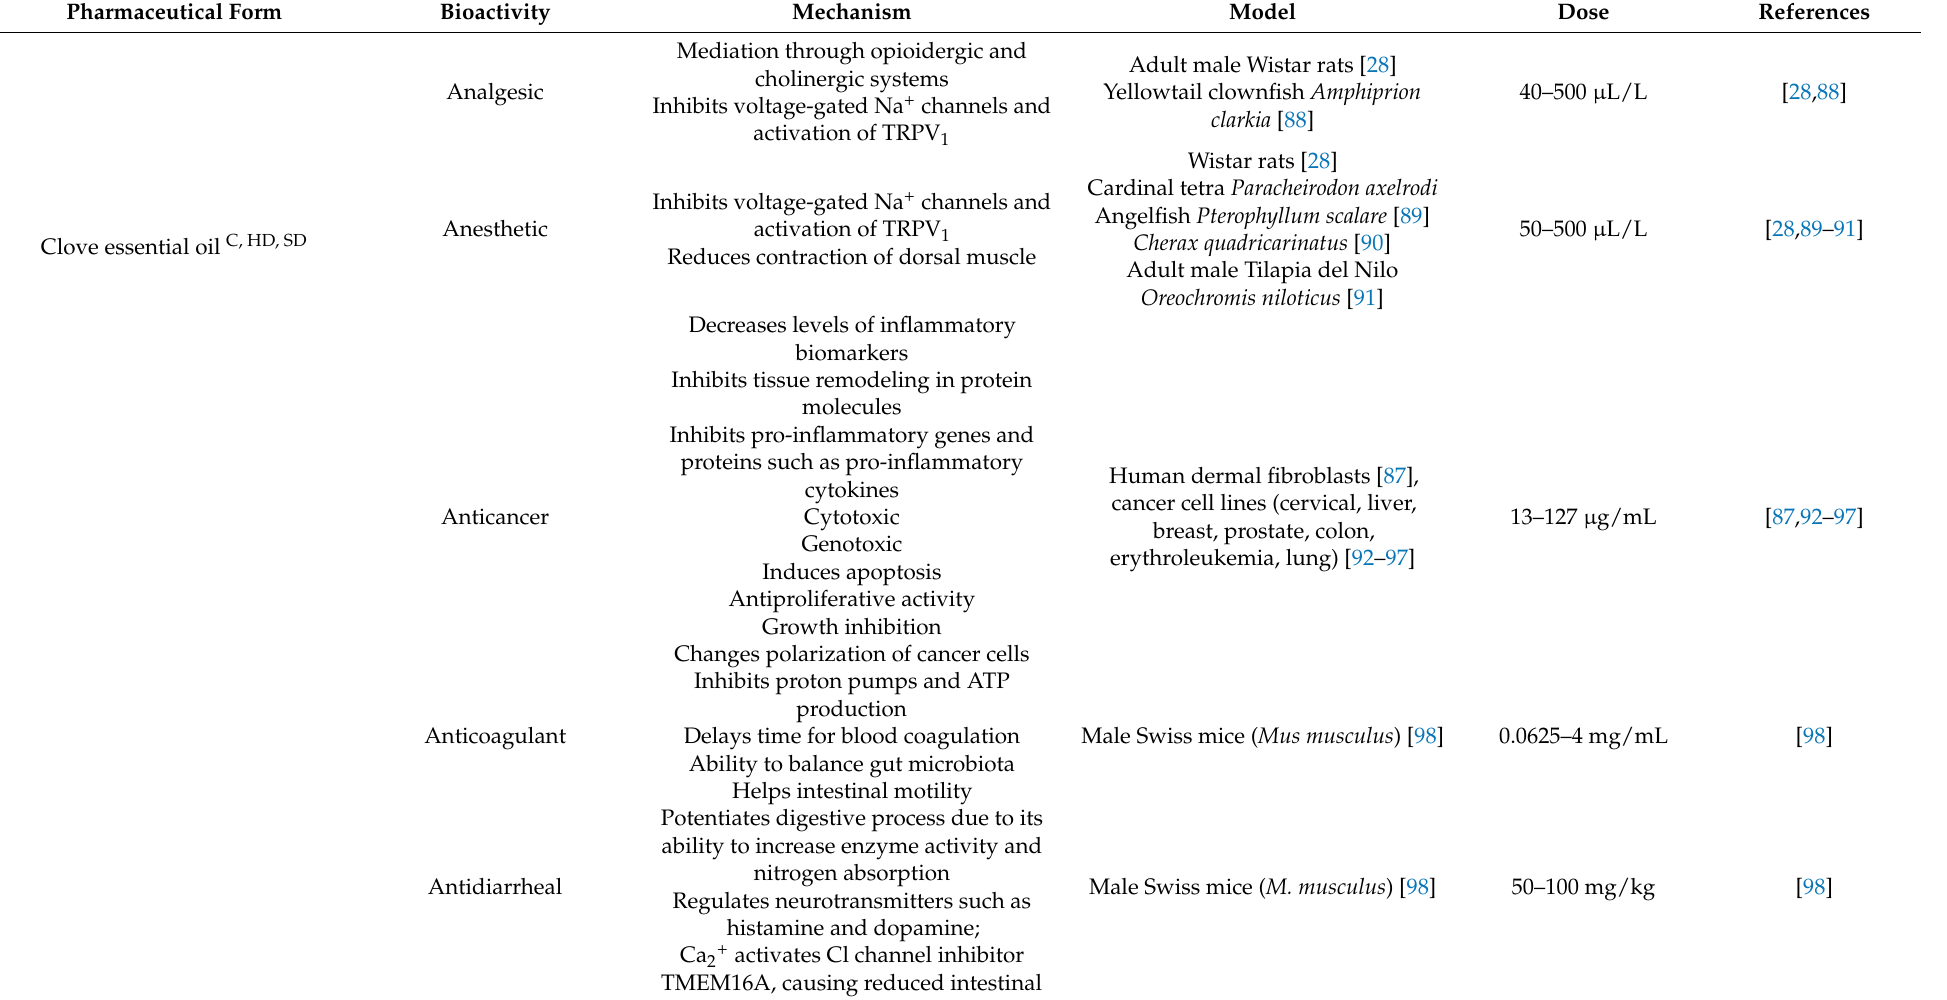
Table 4. Principal biological activities of